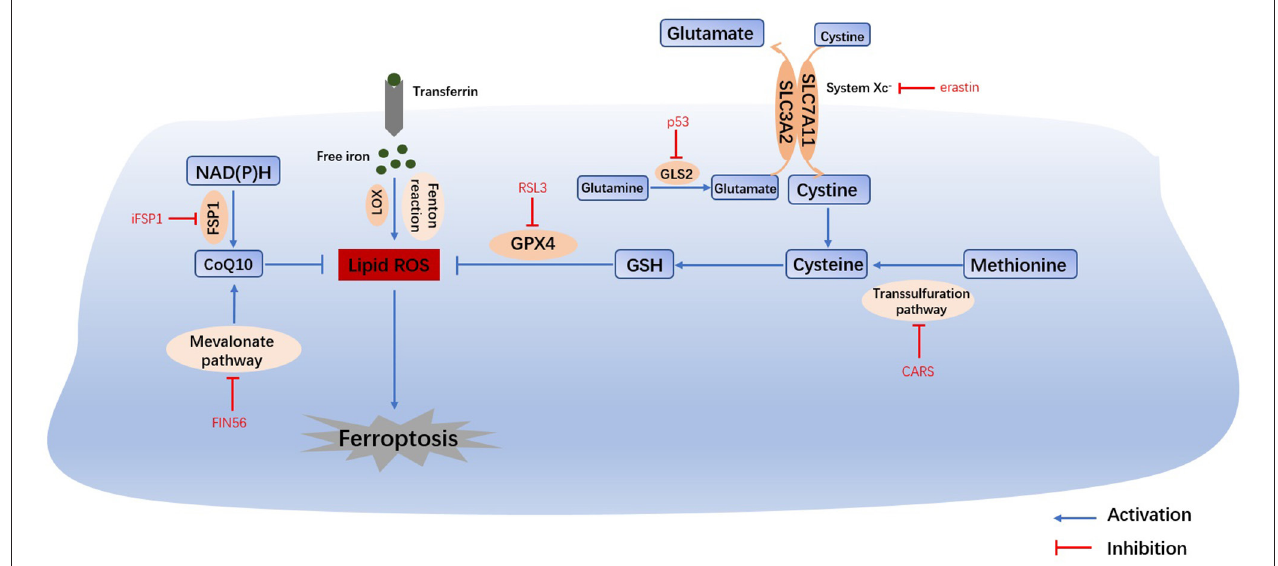
FIGURE 1 | Main mechanisms of ferroptosis. The Fenton reaction, LOX and PUFAs facilitate the generation of lipid ROS. Cysteine can be generated from the uptake of cystine via system Xc- or the transsulfuration pathway. Amino acid metabolism and NAD(P)H, suppresses the synthesis of GSH and CoQ10, thus inhibiting the reduction in lipid ROS. The accumulation of lipid ROS leads to ferroptosis. Therefore, iron homeostasis, lipid peroxidation and amino acid metabolism are the main regulators of ferroptosis. System Xc-, cystine/glutamate transporter; GLS, glutaminase; GSH, glutathione; GPX4, glutathione peroxidase 4; LOX, lipoxygenase; FSP1, ferroptosis suppressor protein 1; CoQ10, coenzyme